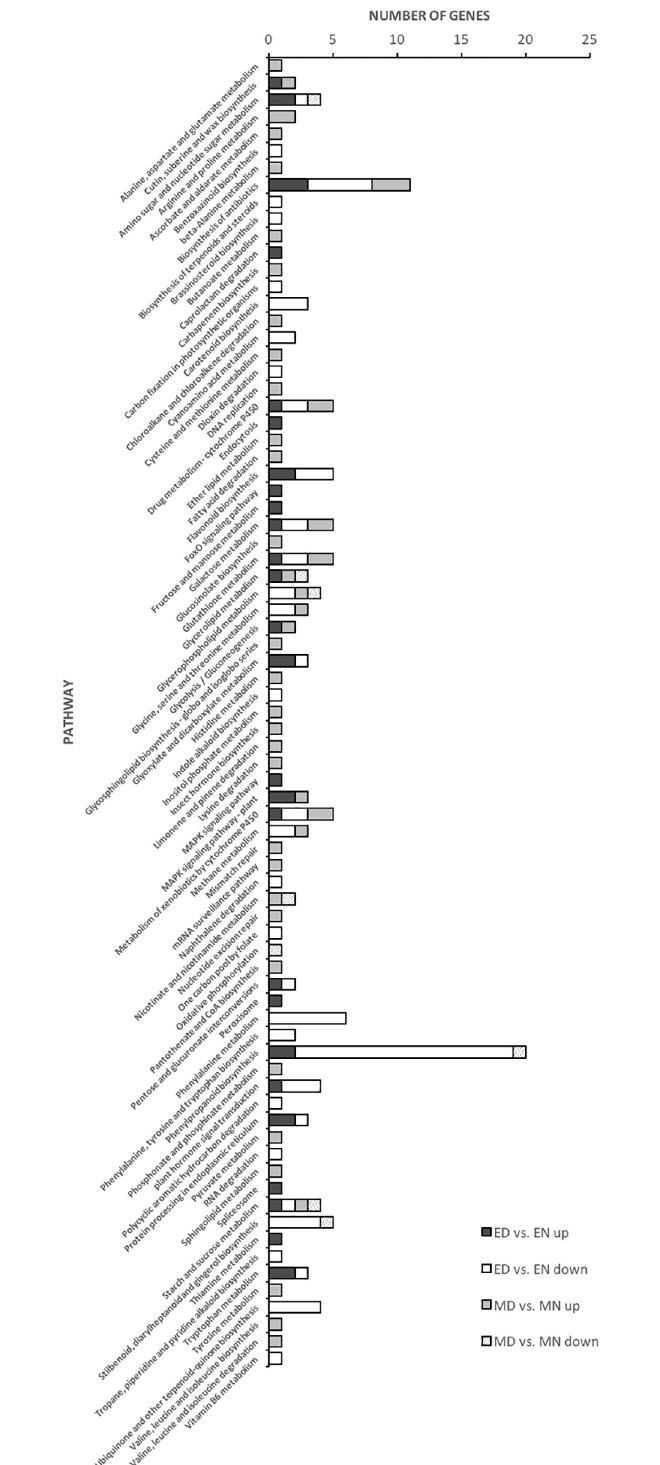
Fig 4. The over-represented unigenes from differential gene expression data of tolerant and sensitive libraries and their KEGG terms. ED, L-82 under drought and EN, L-82 under normal conditions. MD, Marvdasht under drought and MN, Marvdasht under normal